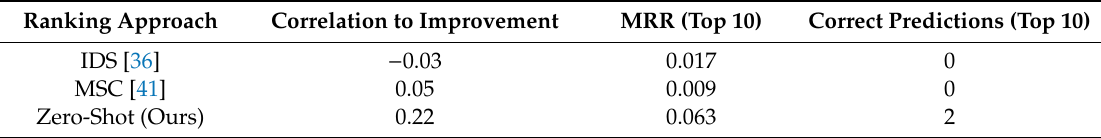
Table 5. Evaluation of each pre-trained model ranking